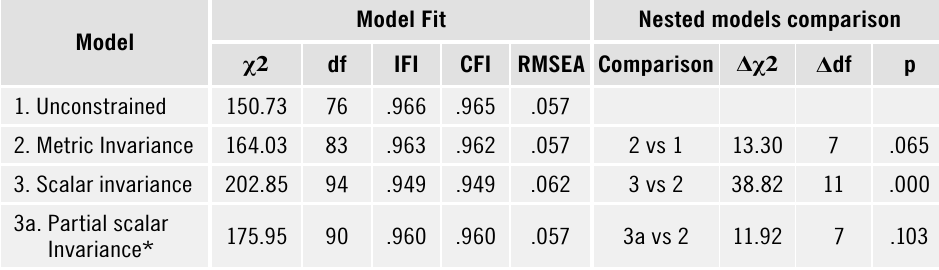
Table 4. Measurement invariance of EMO scale